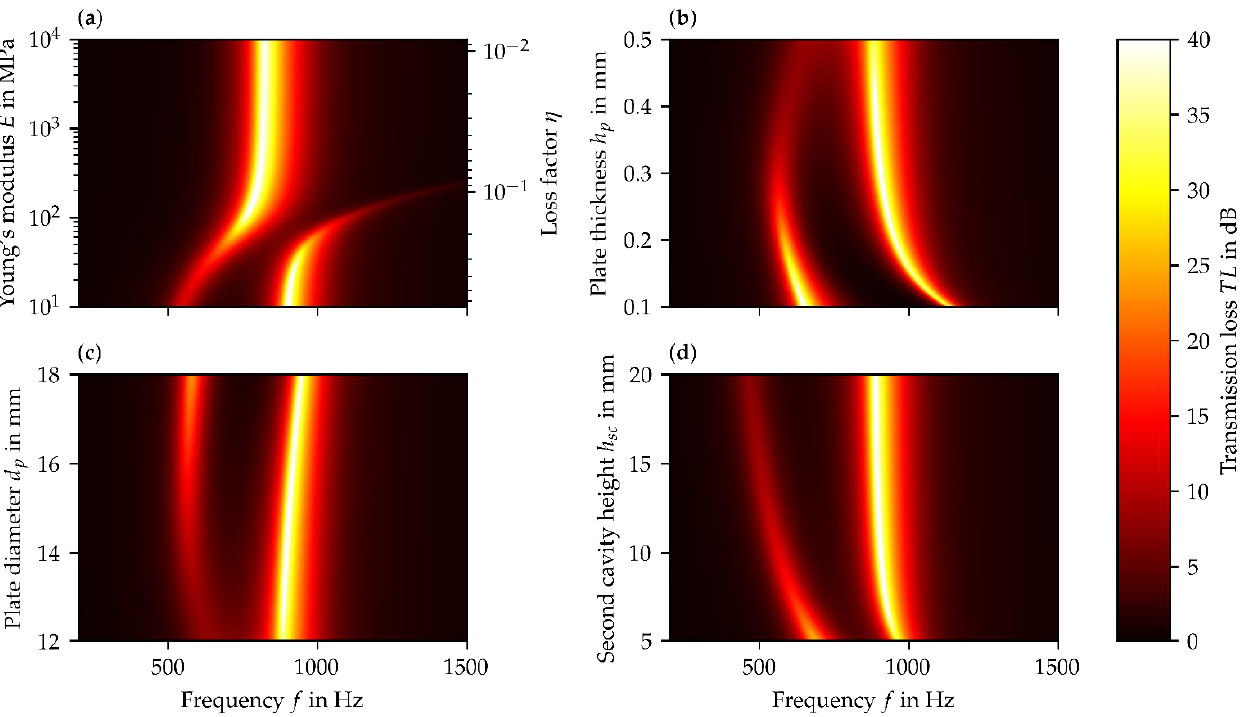
Figure 6. Results of the parameter study of the Helmholtz resonator with flexible walls, ( a ) variation of Young’s modulus 𝐸 and loss factor 𝜂 , ( b ) variation of plate thickness ℎ 𝑝 , ( c ) variation of plate diameter 𝑑 𝑝 , ( d ) variation of second cavity height ℎ 𝑠𝑐 .